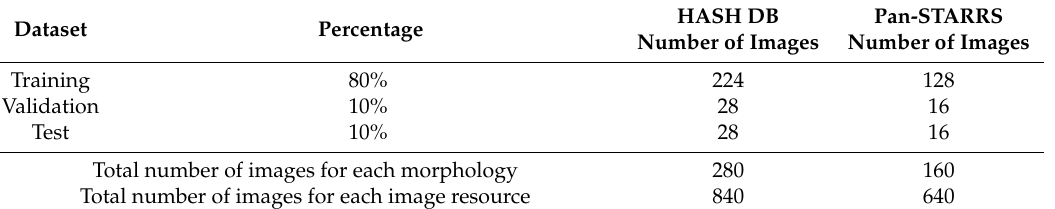
Table 4. Dataset distribution for each type of morphology from HASH DB and